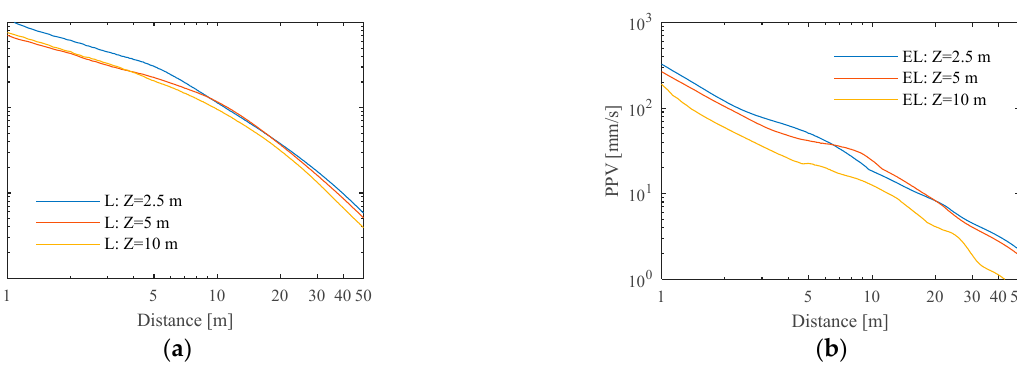
Figure 11. PPV versus distance from the pile due to impact pile driving for different pile penetration depths: ( a ) linear analysis; ( b ) equivalent linear analysis.